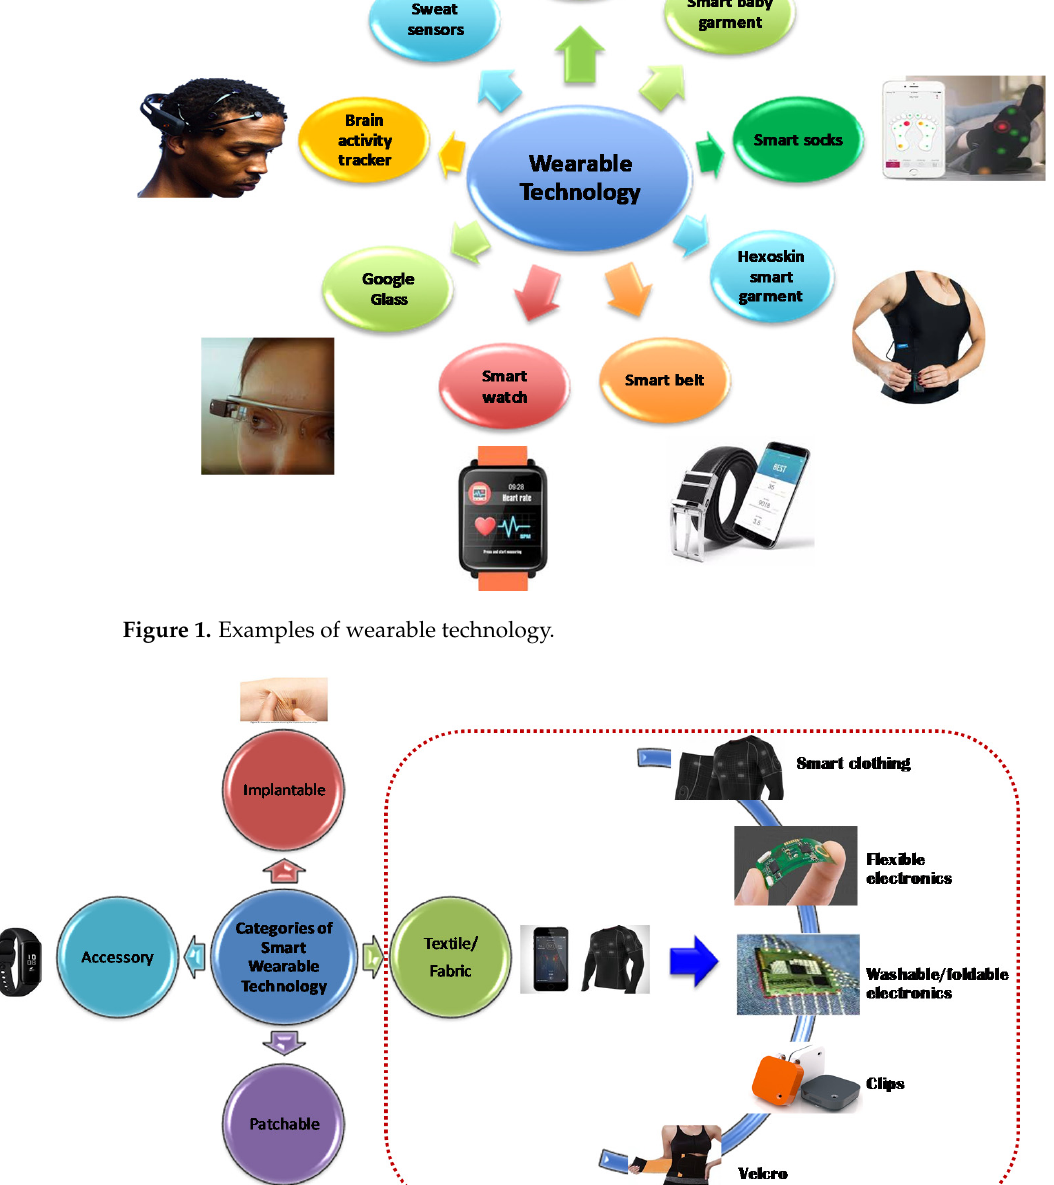
Figure 2. Categories of wearable technology.